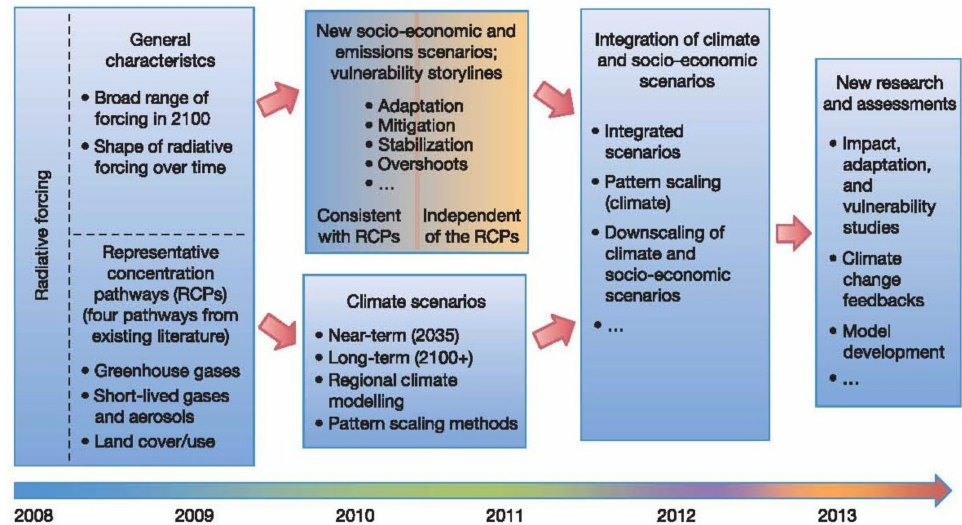
Figure 8. Scenarios began with the identification of radiative forcing characteristics that support modelling of a wide range of possible future climates. Representative concentration pathways (RCPs) are selected from the published literature to provide needed inputs of emissions, concentrations, and land use/cover for climate models. In parallel with development of climate scenarios based on the RCPs, new socio-economic scenarios (some consistent with the radiative forcing characteristics used to identify the RCPs and some developed to explore completely different futures and issues) are developed to explore important socio-economic uncertainties affecting both adaptation and mitigation. Using a variety of tools and methods, such as pattern scaling, the new socio-economic scenarios are integrated with the new climate scenarios. This framing is used to provide insights into the costs, benefits, and risks of different climate futures, policies, and socio-economic development pathways. From [69] with an edited